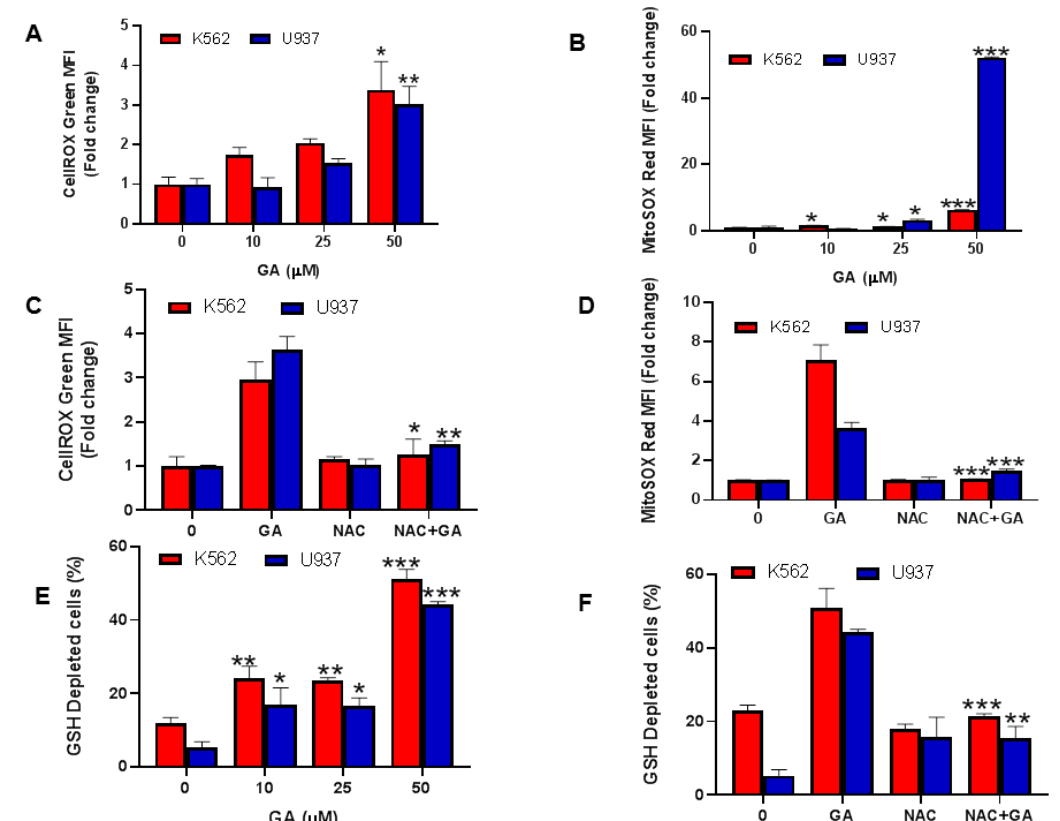
Figure 6. Greensporone A-mediated generation of reactive oxygen species (ROS) in leukemic cells. K562 and U937 were treated with greensporone A for 24 h. ( A – D ) Cellrox and mitoSOX assays were performed to evaluate the level of ROS by flow cytometry as described in Section 2. ( E , F ) Glutathione level was determined by flow cytometry. K562 and U937 cells were treated with greensporone A for 24 h and glutathione level was determined using a ThioTracker assay kit. The graph displays the mean ± SD (standard deviation) fold change release of ROS of three experiments (* P < 0.05, ** P < 0.01, *** P < 0.001).